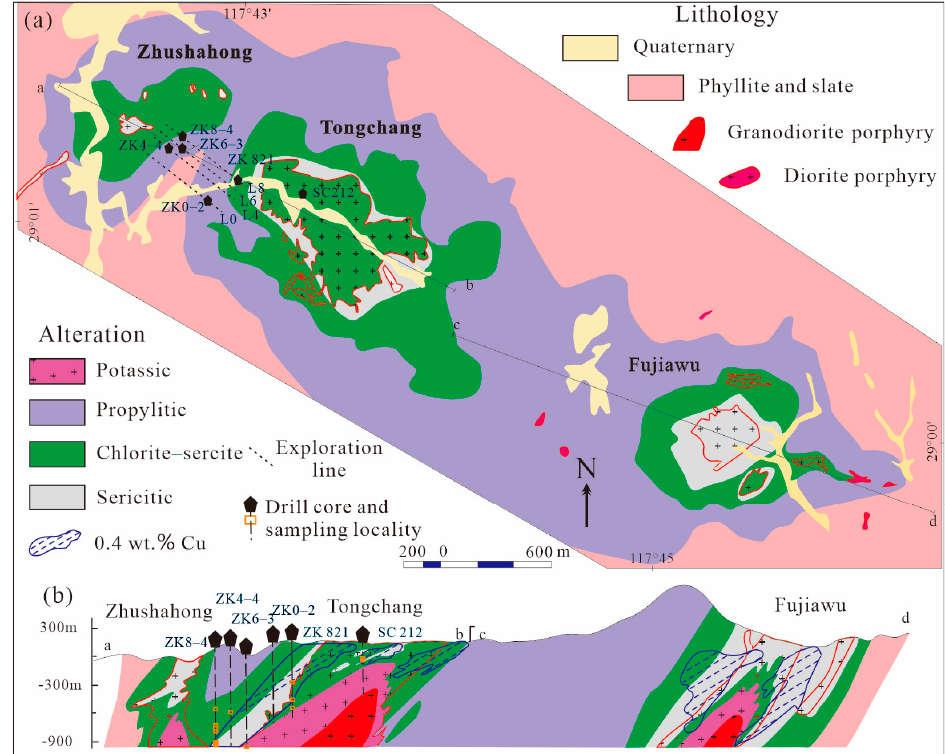
Figure 2. ( a ) A geological map of the Dexing porphyry Cu district; ( b ) Two cross sections (a–b, and c–d) of the Cu district (adapted from [19,38]). Dash lines denoted with L0-8 represents exploration lines; black pentagons represent the locations of drill hole, and the sampling localities are marked with small rectangles.